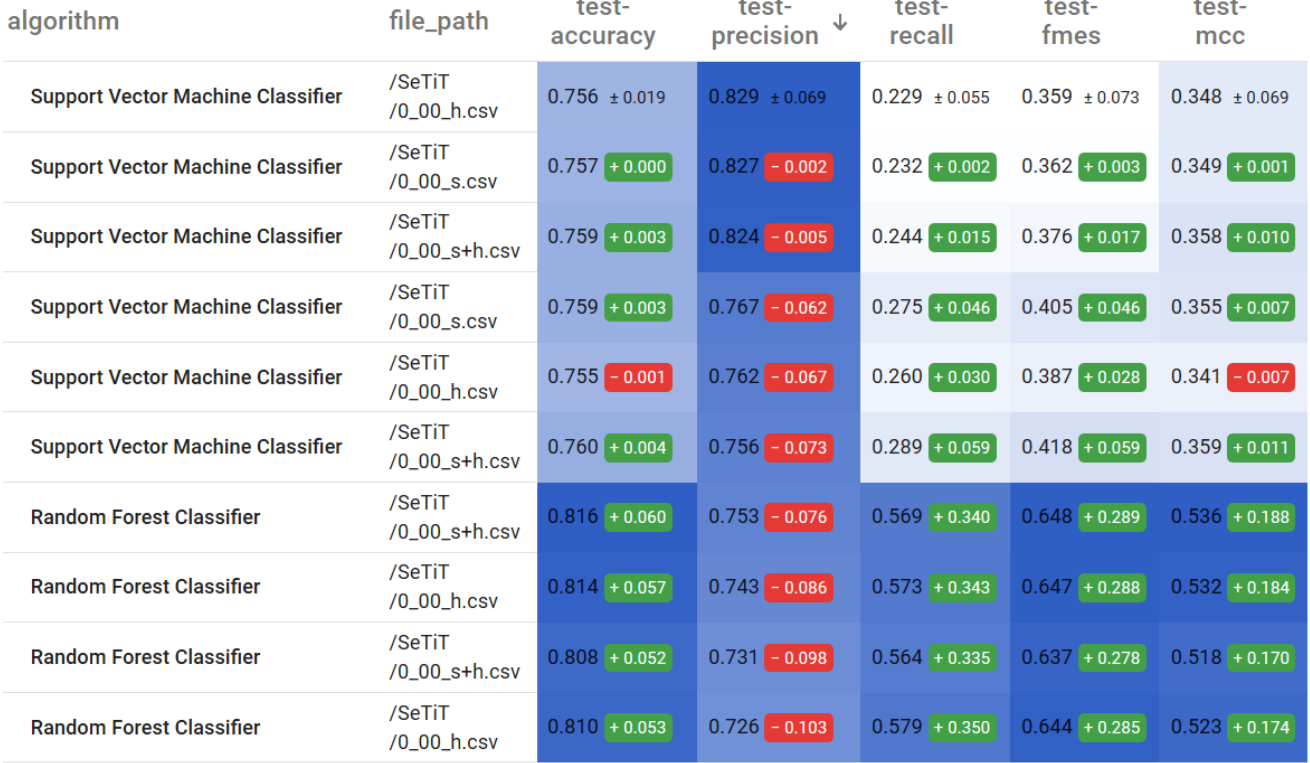
Figure 7. Top 10 precision measures.